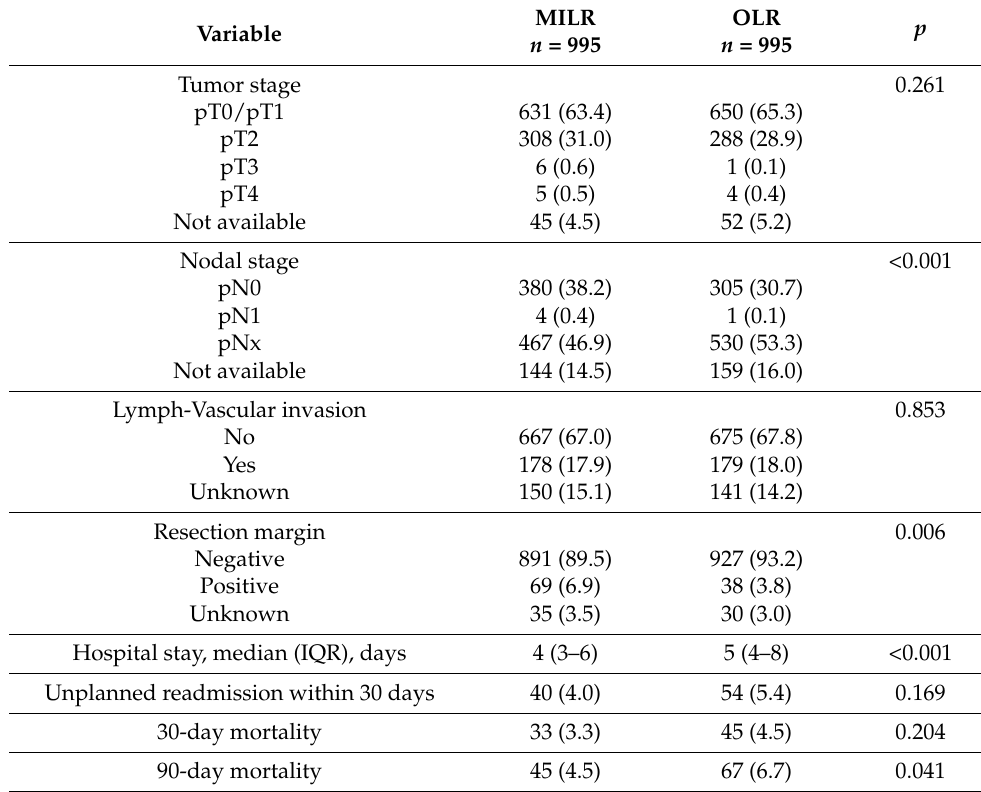
Table 2. Pathological and Early Postoperative Outcomes of Patients with Hepatocellular Carcinoma in the Matched Data